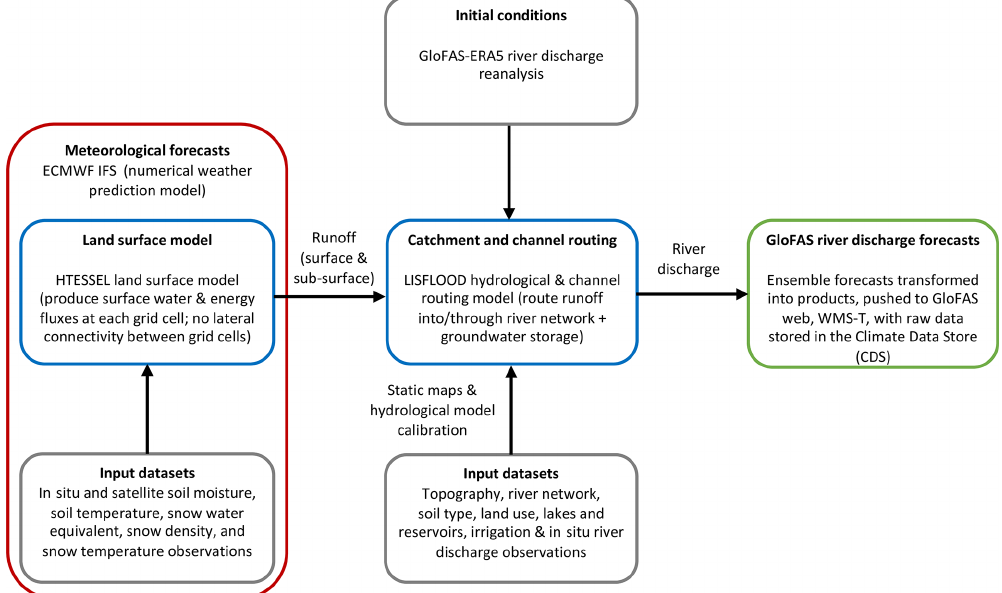
Figure 1. Key components of GloFAS version